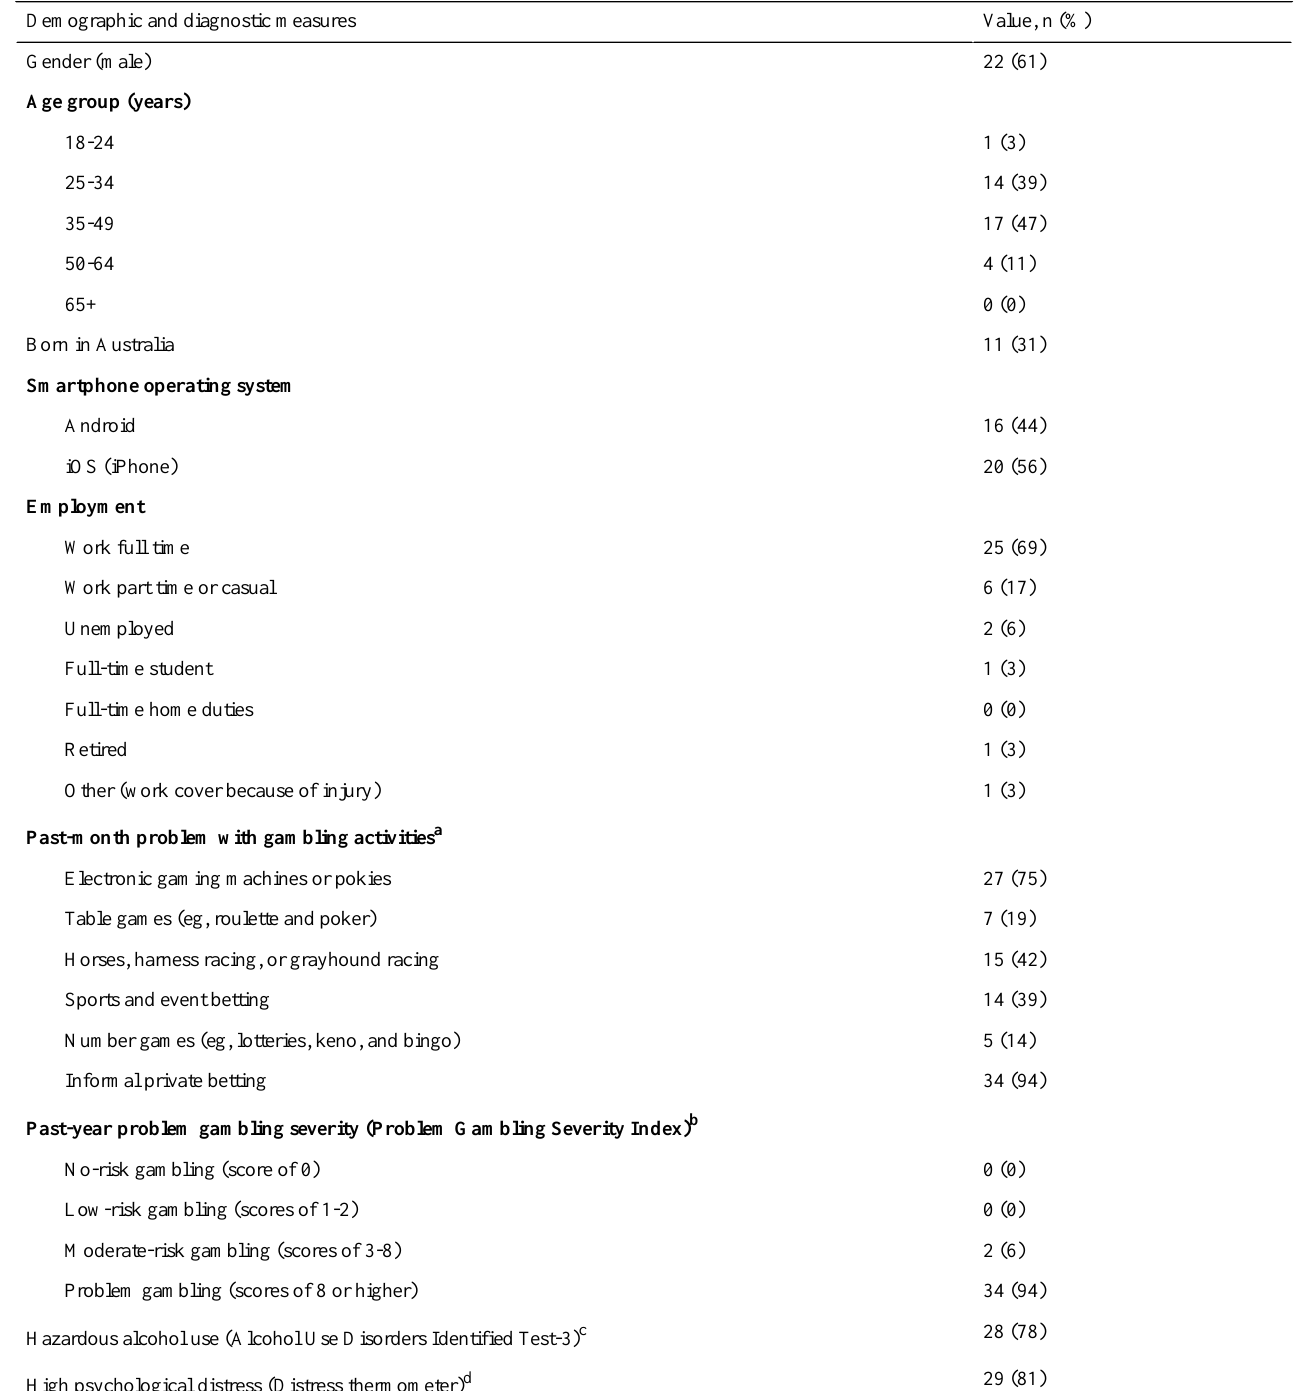
Table 1. Descriptive statistics for the overall sample at baseline